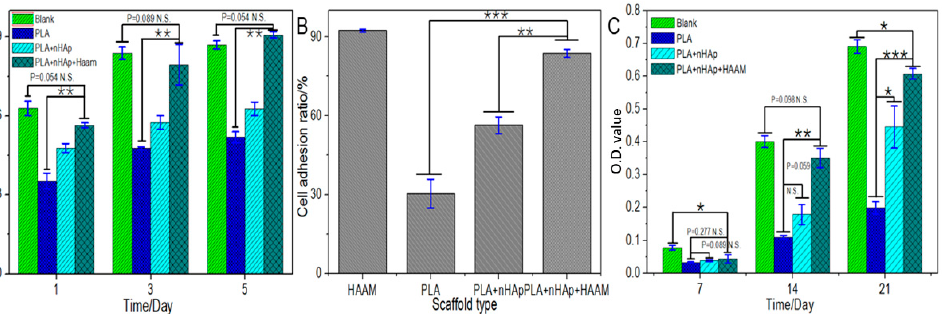
Figure 8. Osteoblasts’ proliferation ( A ) on different scaffolds ( B ), adhesion rate ( C ) and ALP quantitative testing. Data are indicated by mean ± SD. *: p < 0.05; **: p < 0.01; ***: p < 0.001.